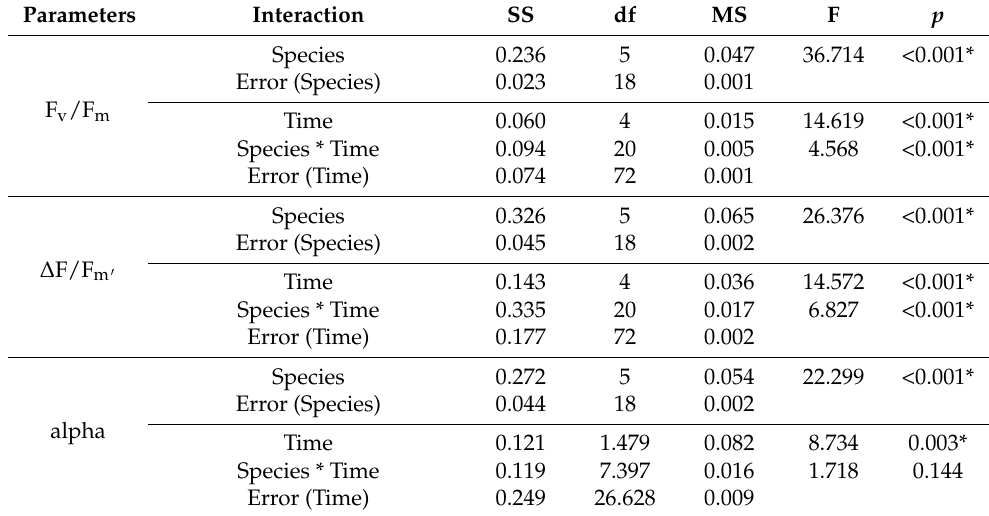
Table 1. Two-way repeated ANOVA summary